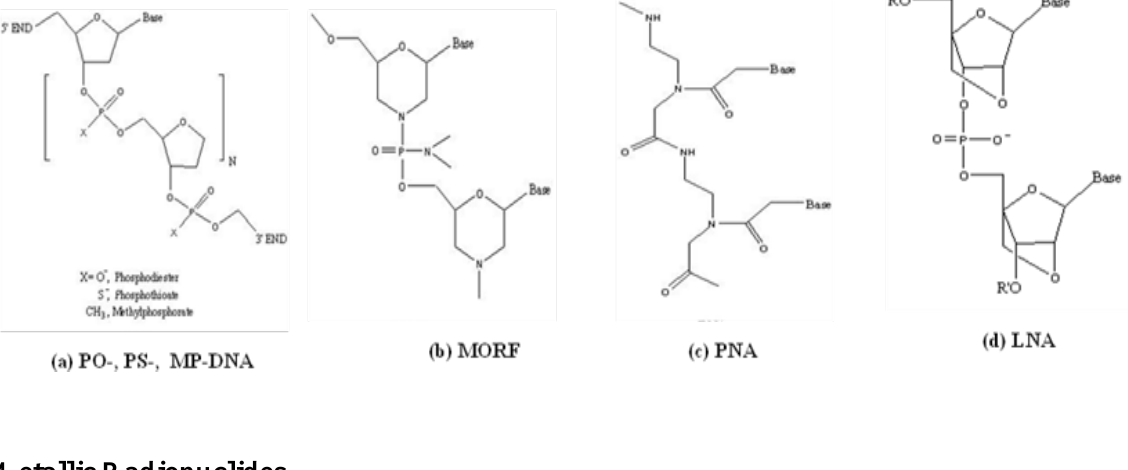
Figure 1. Chemical structures of DNAs and several important analogs. (a) phosphodiester (PO), phosphorothioate (PS) and methylphosphonate (MP) DNAs; (b) phosphorodiamidate morpholino (MORF); (c) peptide nucleic acids (PNA); (d) locked nucleic acids